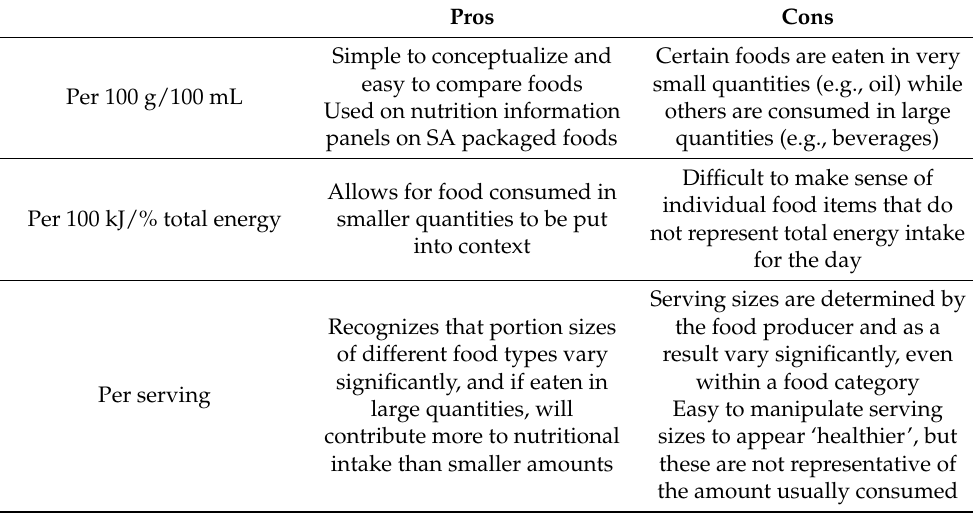
Table 4. Pros and cons of different base